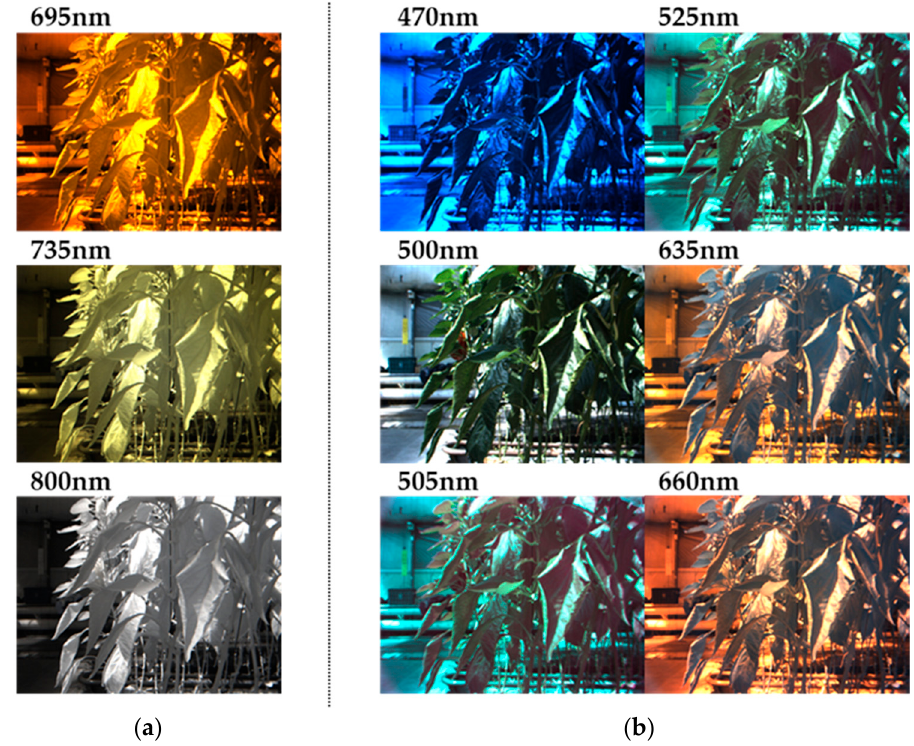
Figure 6. Image comparison between (a) images of 695, 735, and 800 nm wavelength and (b) images at 470, 500, 505, 525, 635, and 660 nm wavelength.